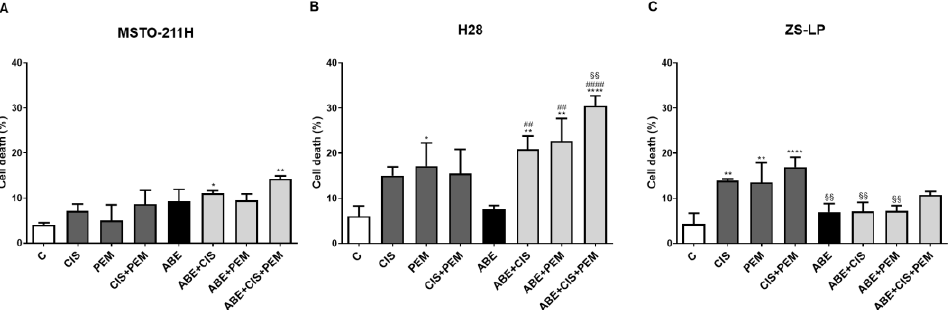
Figure 3. Effects of abemaciclib in association with cisplatin and pemetrexed on cell death in MPM cell lines. ( A ) MSTO-211H cells were treated with abemaciclib (0.5 µ M), cisplatin (0.3 µ M), and pemetrexed (0.02 µ M), or with the simultaneous combination of abemaciclib and chemotherapy for 72 h. ( B ) H28, and ( C ) ZS-LP cells were exposed to the above-described treatments, using abemaciclib 1 µ M, cisplatin 1 µ M, and pemetrexed 0.05 µ M. The percentage of dead cells stained with Hoechst 33,342 and Propidium Iodide is shown. Data are expressed as a percentage of cell death and are the medians of three separate experiments. Comparison among groups was made by using analysis of variance (one-way ANOVA), followed by Bonferroni’s post-test. * p < 0.05, ** p < 0.01, **** p < 0.0001 vs. control cells; §§ p < 0.01, vs. cisplatin + pemetrexed-treated cells; ## p < 0.01, #### p < 0.0001 vs. abemaciclib-treated cells.